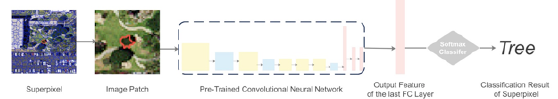
Figure 2. Framework of per-superpixel SCNN method (taking